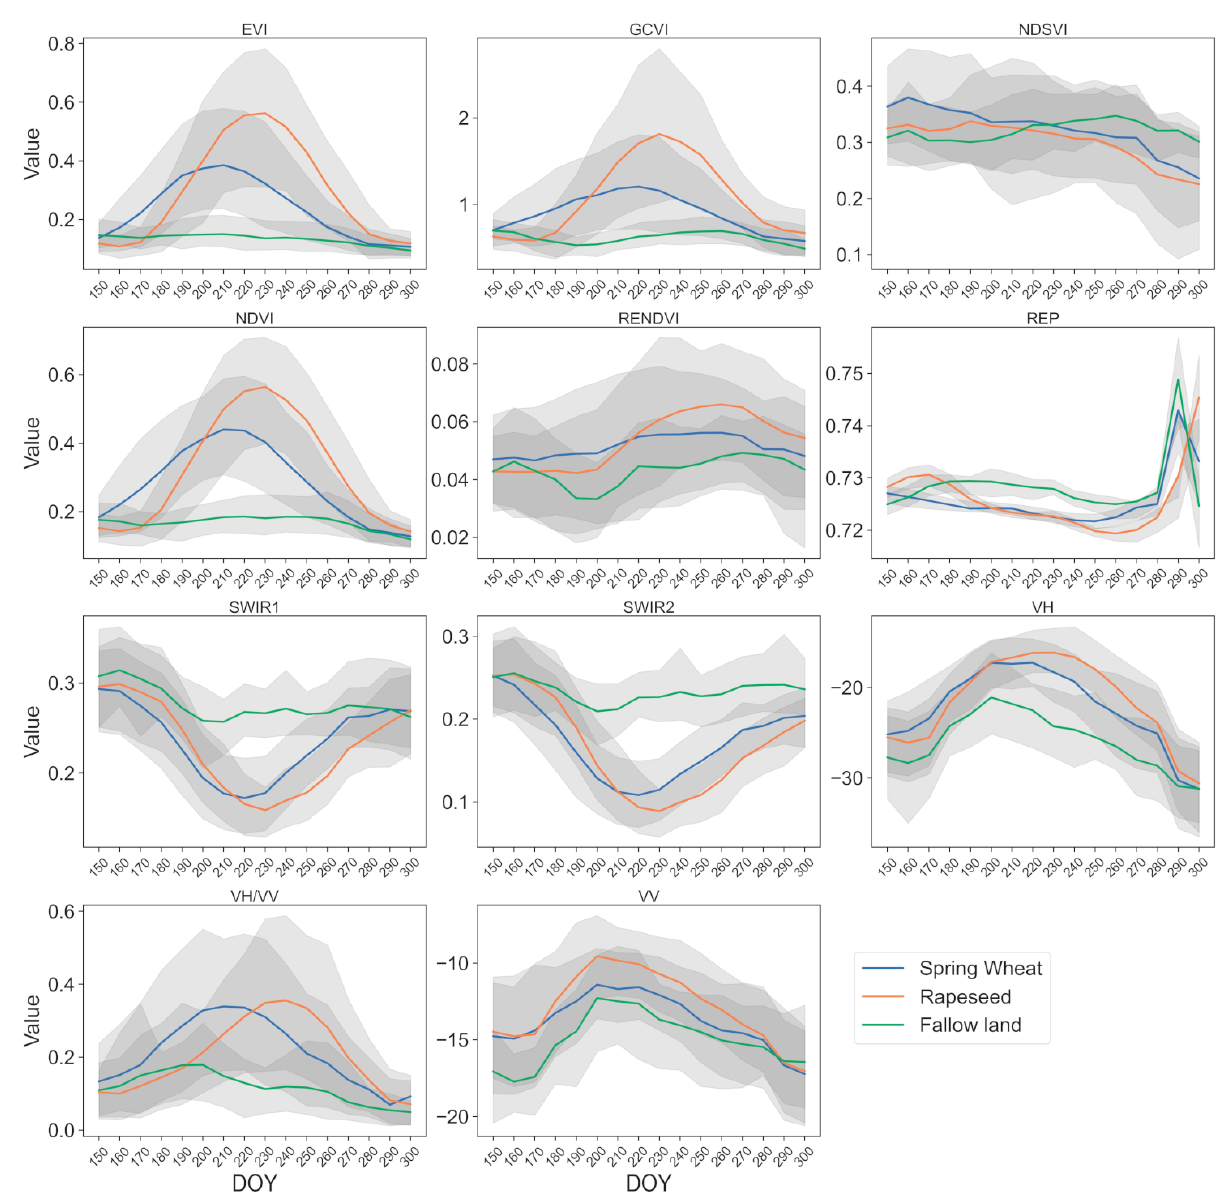
Figure 6. Temporal profile of remote sensing indicators for spring wheat, rapeseed, and fallow land (Note: the grey represents the standard deviation of indicators for specific